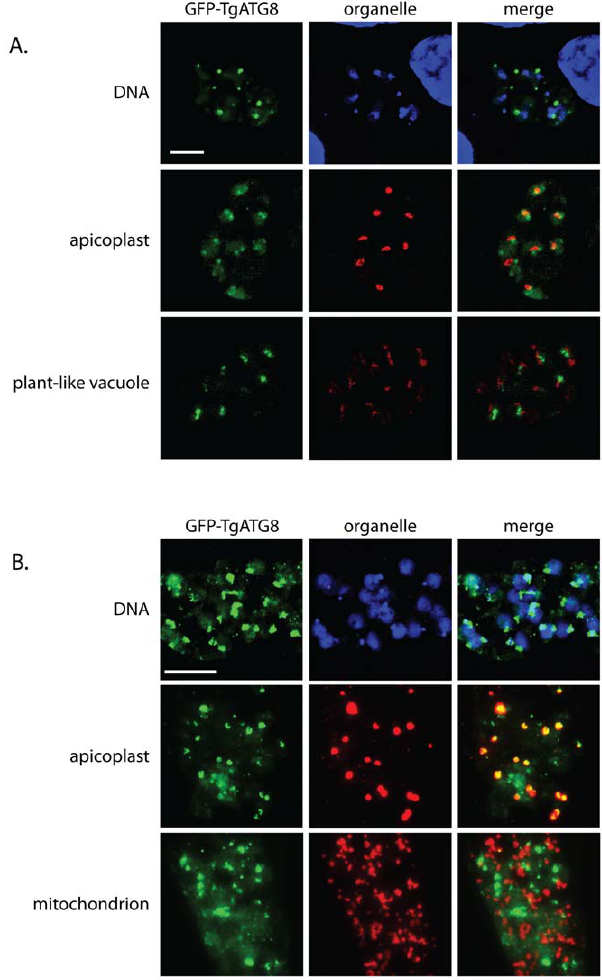
Figure 5. ATG8 colocalizes with the apicoplasts after pro- longed monensin exposure. Deconvolved immunofluorescence micrographs showing relative localization of GFP-ATG8 and T. gondii intracellular structures after exposure to monensin (0.75 ng/ml). (A) 3 hours monensin exposure showing localization of GFP-ATG8 and DNA, apicoplasts, and plant-like vacuoles. (B) 24 hours monensin exposure showing localization of DNA, apicoplasts, and mitochondria. Scale bar=10 m m.